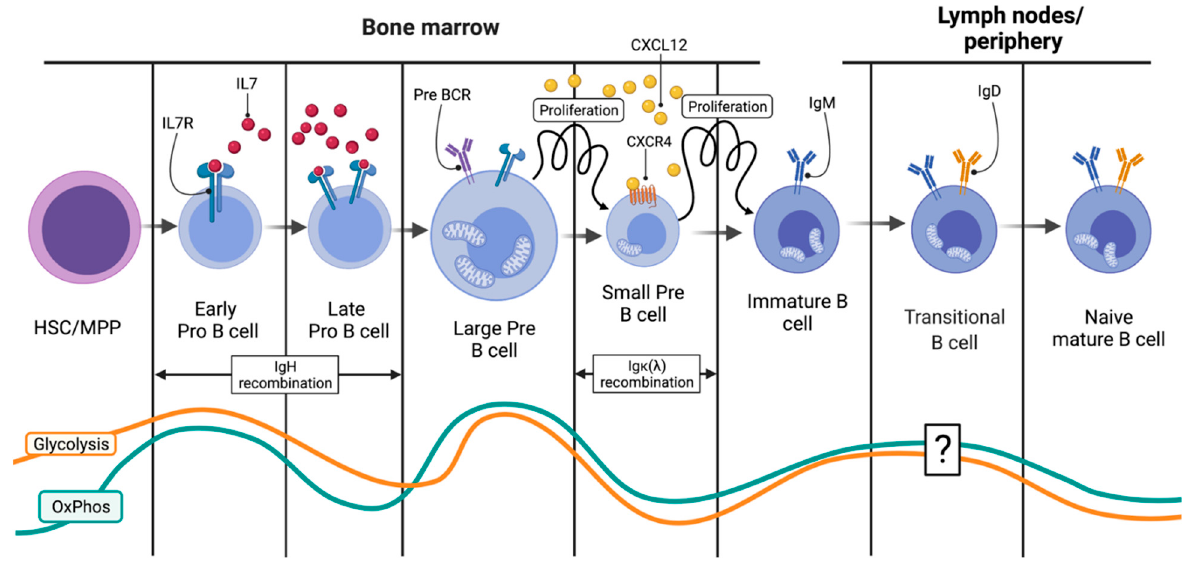
Figure 3. The first half of B cell lymphopoiesis happens inside the BM and results in immature IgM-expressing B cells in the periphery. Visual summary of the initial events that lead to the formation of IgM + immature B cells and that happen inside the BM. Close control of differentiation and replication is needed to avoid malignant transformation during active Ig recombination. This is achieved through both tight metabolic regulation as well as sequential trafficking of the B cell lineage between specific BM niches (from the IL7-rich to the CXCL12 one). Bioenergetic swifts are of particular interest and are specifically shown in this diagram as orange (glycolysis) and blue (OxPhos) lines. IL7(R): Interleukin 7 (receptor), CXCR4: C-X-C Motif Chemokine Receptor 4, CXCL12: C-X-C Motif Chemokine Ligand 12. Created with BioRender.com.